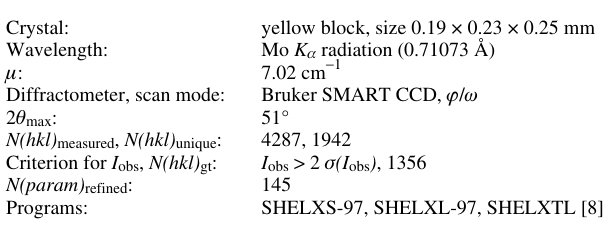
Table 1. Data collection and